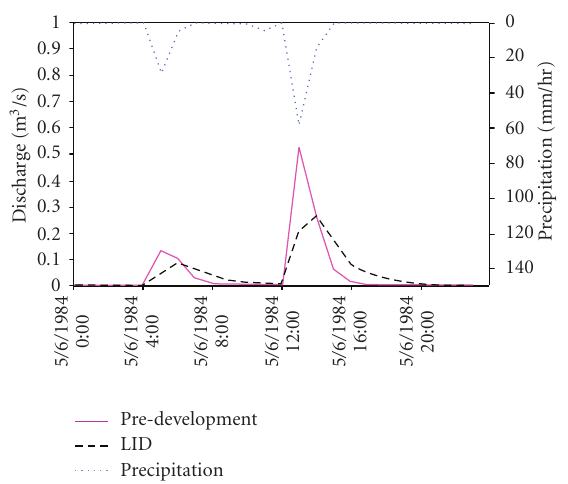
Figure 12: Sumner Point Precipitation and modeled Total Surface Runo ff on 6 May